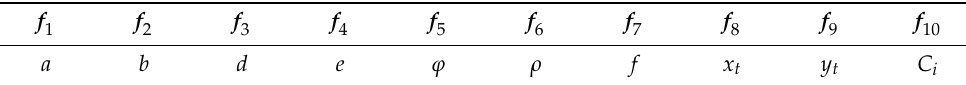
Table 5. Definition of vector F